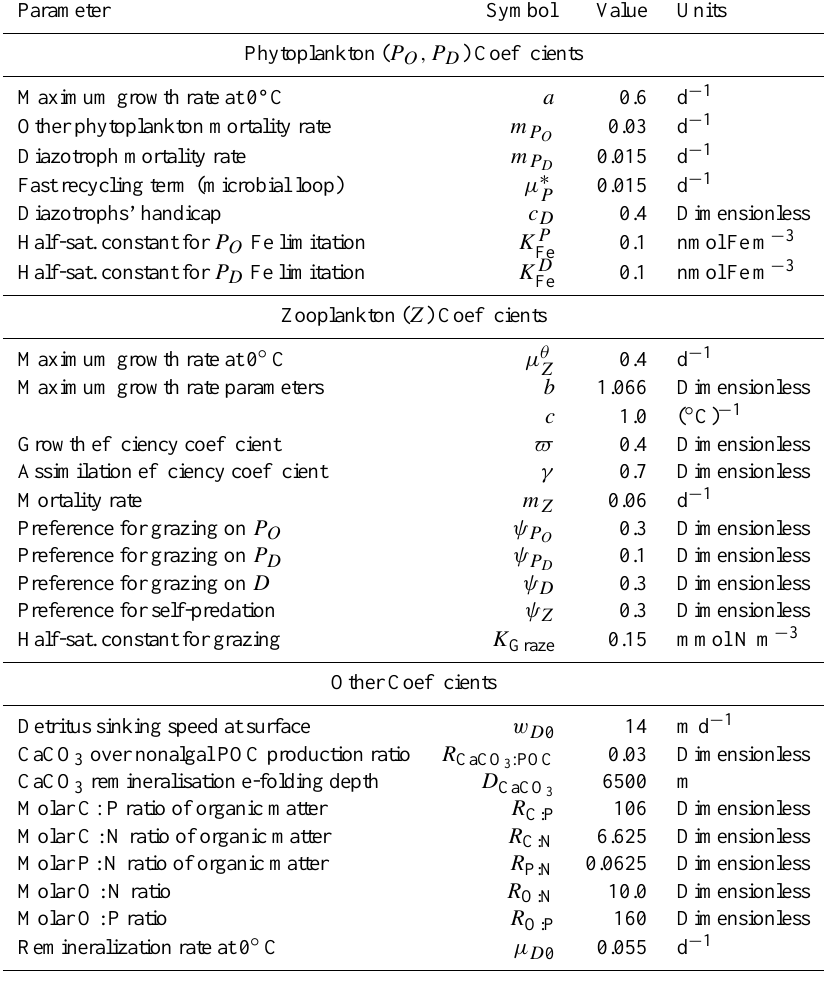
Table 1. Model parameters.